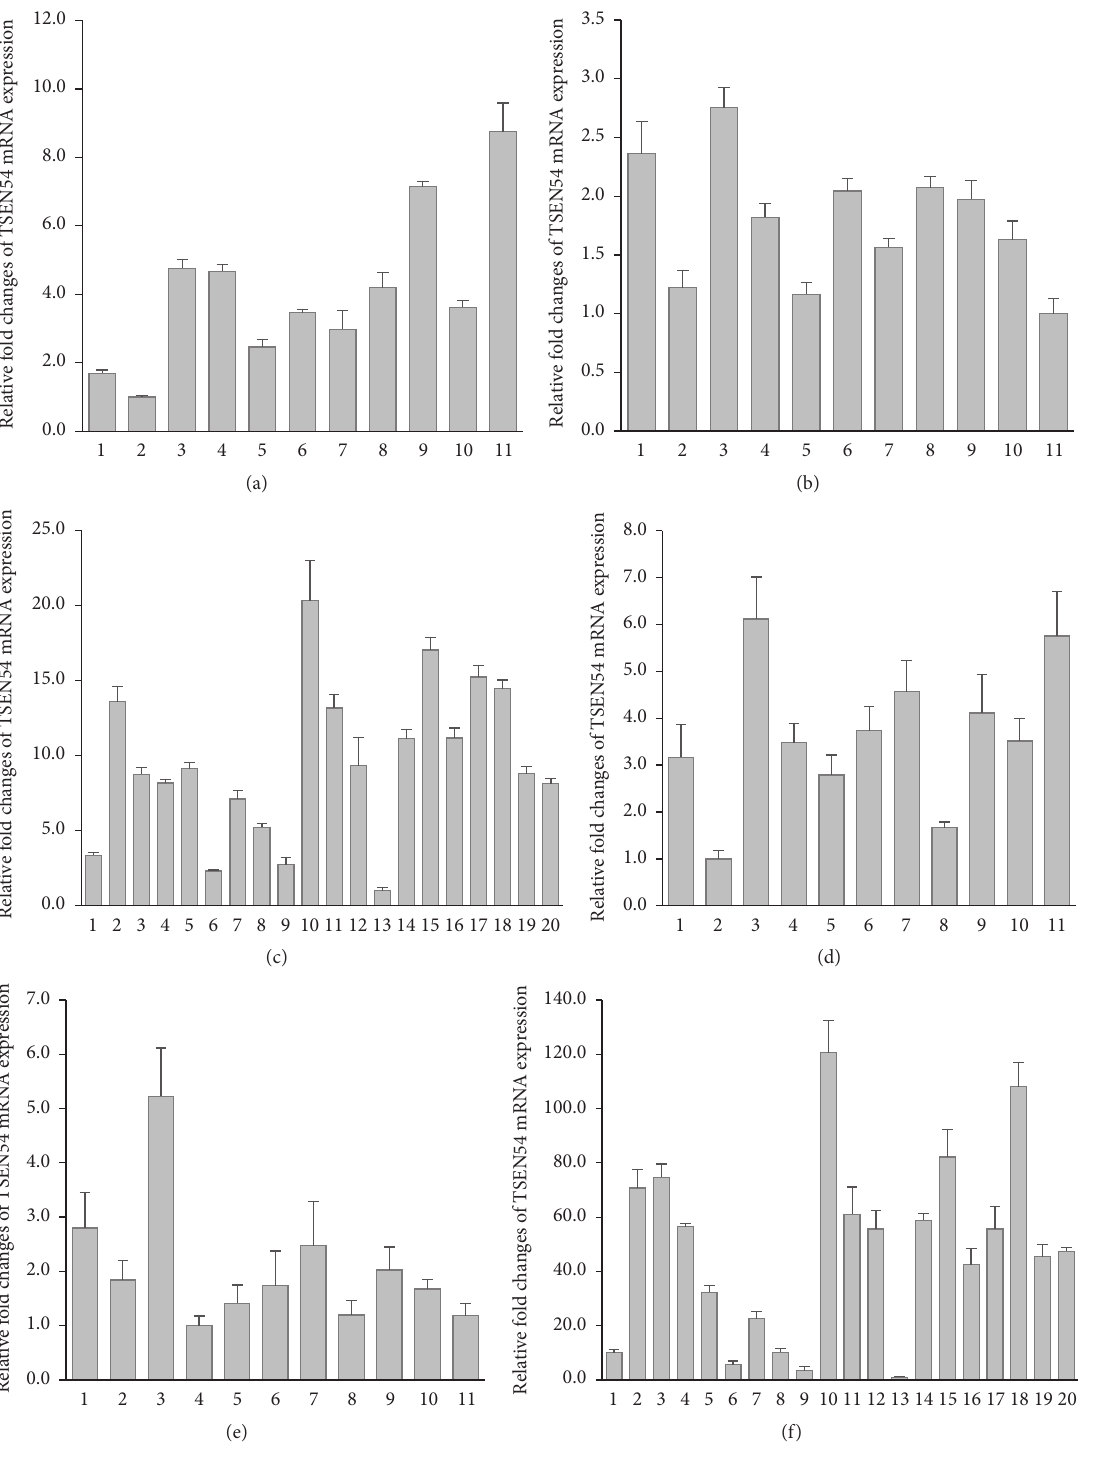
Figure 4: Real-time RT-qPCR analysis of TSEN54 original and Alu -exonized transcripts in various tissues of cynomolgus, rhesus monkey, and human. Expression pattern of TSEN54 original transcript in cynomolgus monkey (a), rhesus monkey (b), and human (c). Expression pattern of Alu -exonized transcript in cynomolgus monkey (d), rhesus monkey (e), and human (f). Cynomolgus monkey panels: 1, cerebellum; 2, cerebrum; 3, kidney; 4, colon; 5, liver; 6, lung; 7, pancreas; 8, small intestine; 9, spleen 10, stomach; 11, testis. Rhesus monkey panels: 1, cerebellum; 2, cerebrum; 3, kidney; 4, colon; 5, liver; 6, lung; 7, pancreas; 8, small intestine; 9, spleen 10, stomach; 11, ovary. Human panels: 1, bone marrow; 2, whole brain; 3, fetal brain; 4, colon; 5, small intestine; 6, heart; 7, kidney; 8, liver; 9, fetal liver; 10, lung; 11, placenta; 12, prostate; 13, skeletal muscle; 14, spinal cord; 15, spleen; 16, stomach; 17, testis; 18, thymus; 19, trachea; 20,